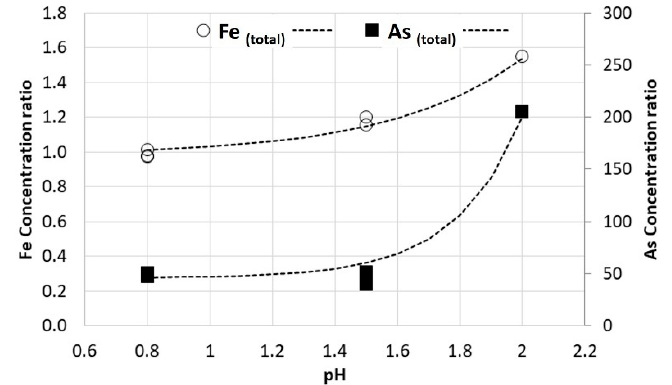
Figure 7. Changes in Fe and As concentrations in the leach residues as a function of the pH (0.8 to 2.0).